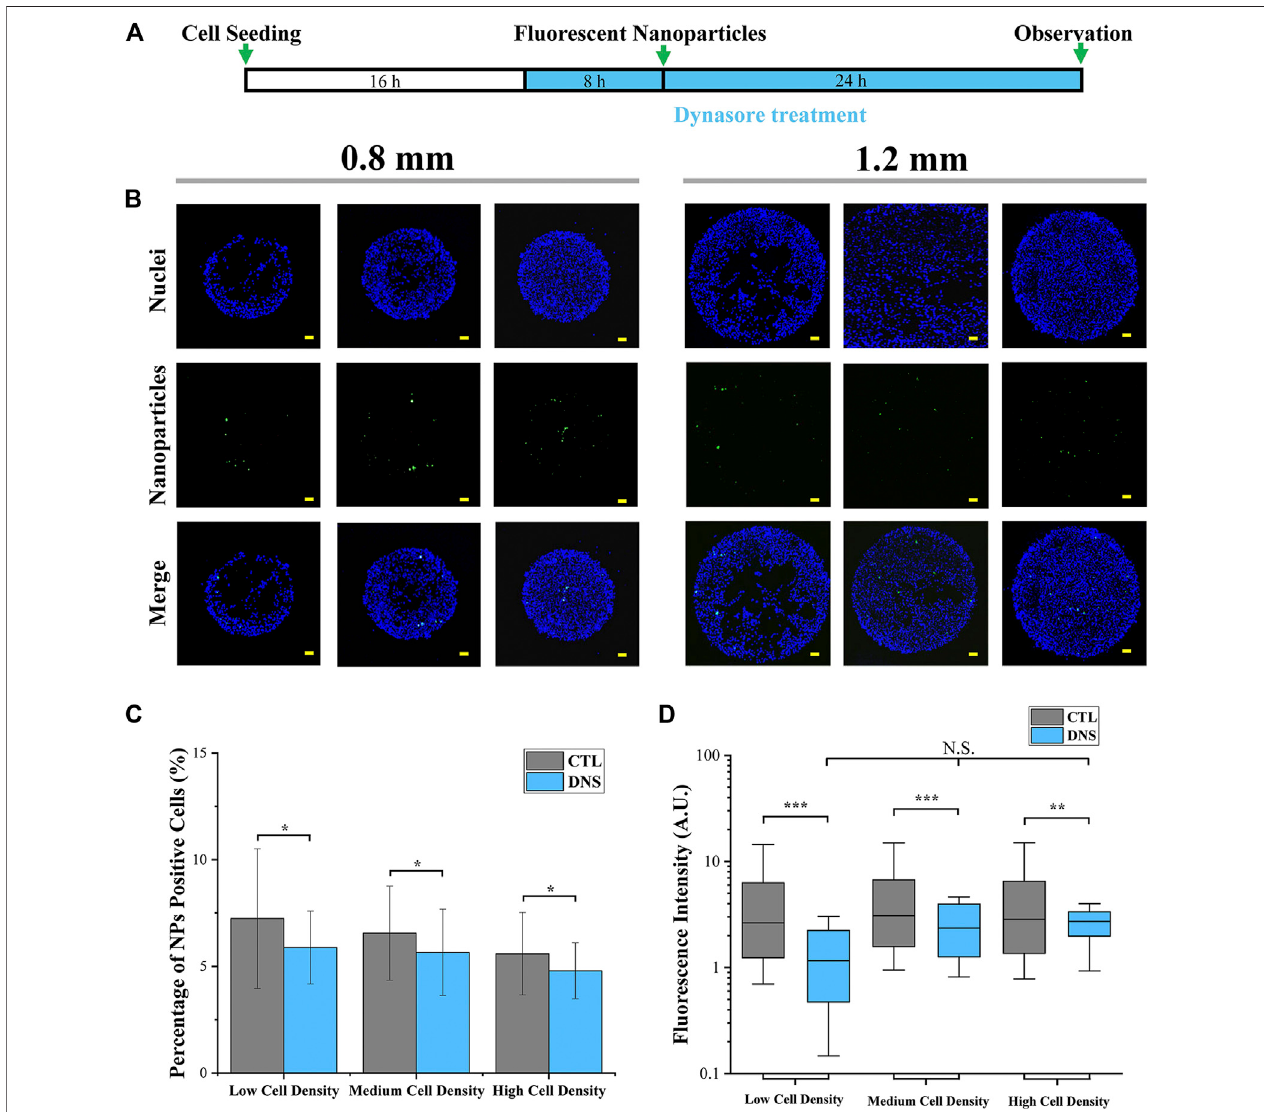
FIGURE 7 | In fl uence of dynamin on cellular uptake capacity. (A) Scheme of dynasore treatment. (B) Representative fl uorescent images of cellular uptake after dynasore treatment. Scale bar: 50 μ m. (C) Percentage of NP-positive cells after dynasore treatment (1.2 mm). Data are presented as means ± SDs ( n > 30). (D) Fluorescence intensity of NP-positive cells after dynasore treatment (1.2 mm). Data are presented as means ± SDs ( n > 300). * p < 0.05, *** p < 0.001.